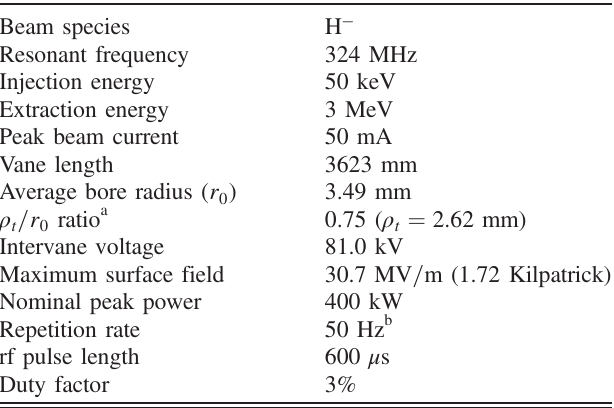
TABLE I. Design parameters of J-PARC RFQ III. Beam species H